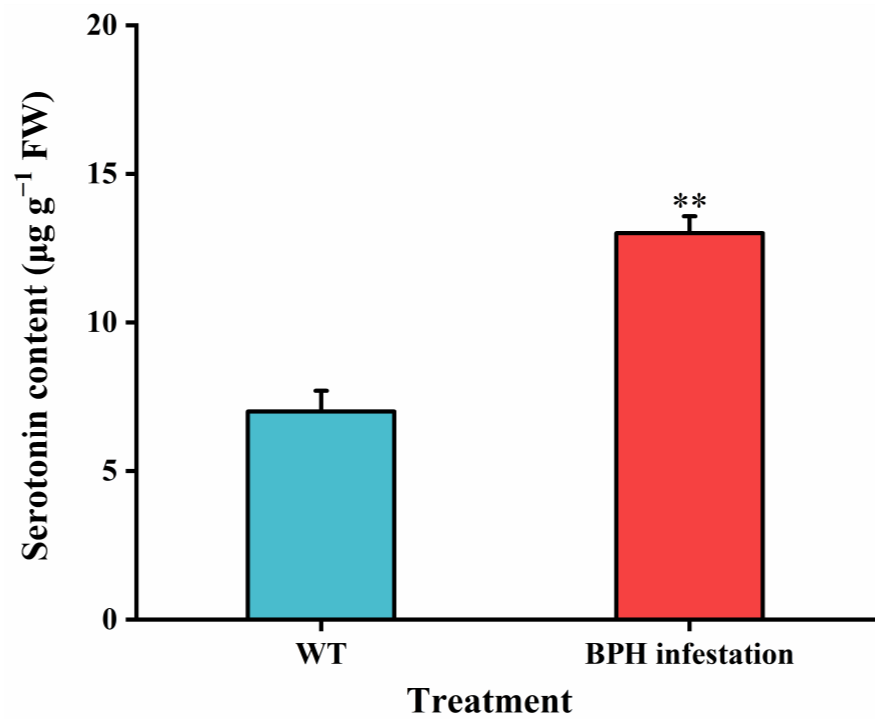
Figure 3. Influence of BPH nymph infestation on the accumulation of serotonin in rice plants. The data are means (+SE) of serotonin content in rice plants at 8 h post infestation without (WT) or with BPH nymphs. FW, fresh weight. Asterisks indicate significant differences in BPH-infested plants compared with non-infested plants (WT) (**, p < 0.01; Student’s t -test).